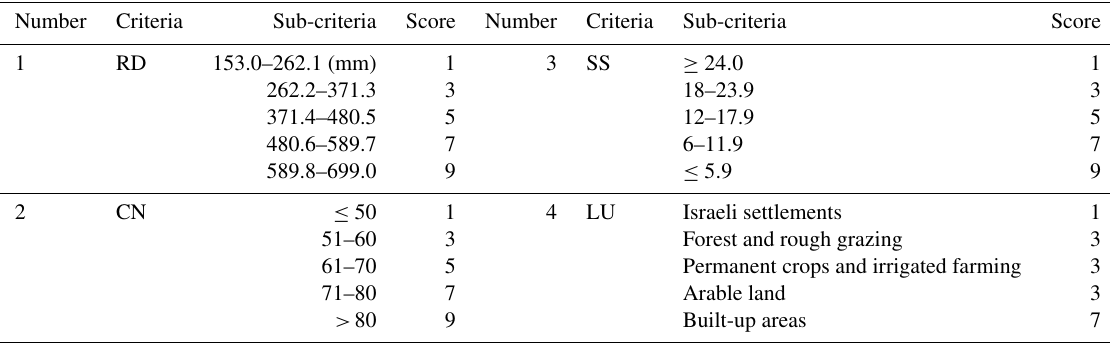
Table 5. The domestic rainwater harvesting suitability scoring assigned for the